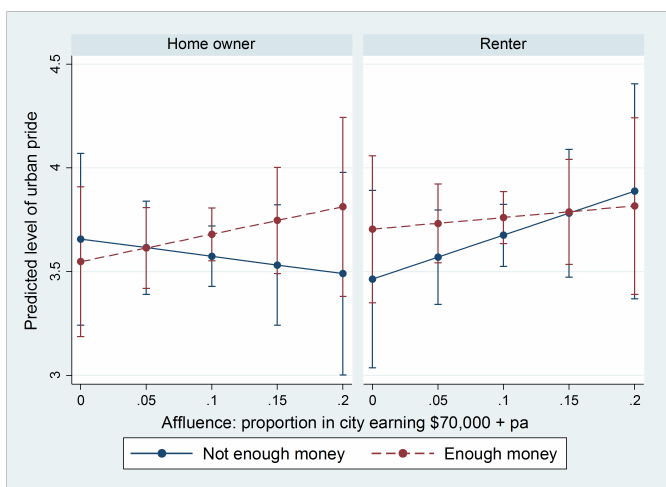
Figure 4: The effect of ‘not having enough money’ on urban pride in more affluent cities by housing tenure. New Zealand,